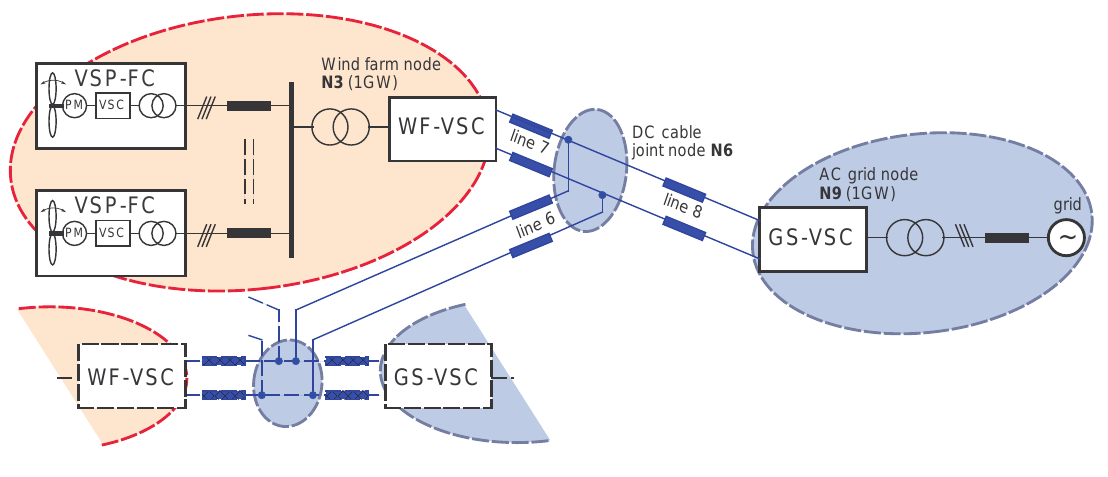
Figure 2. Components of the modeled MTDC grid (DE